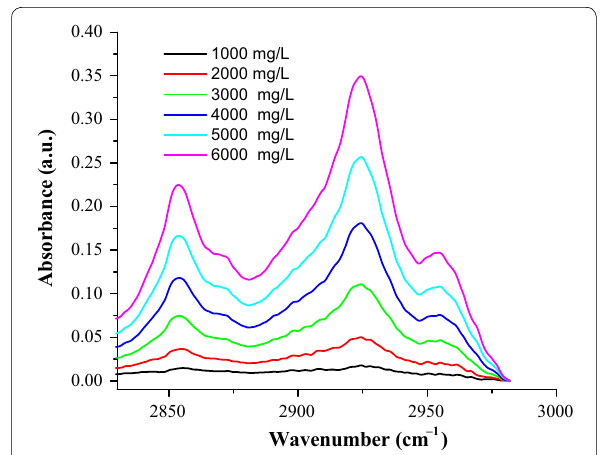
Fig. 1 FT‑IR‑ATR absorption spectra of standard caffeine in water